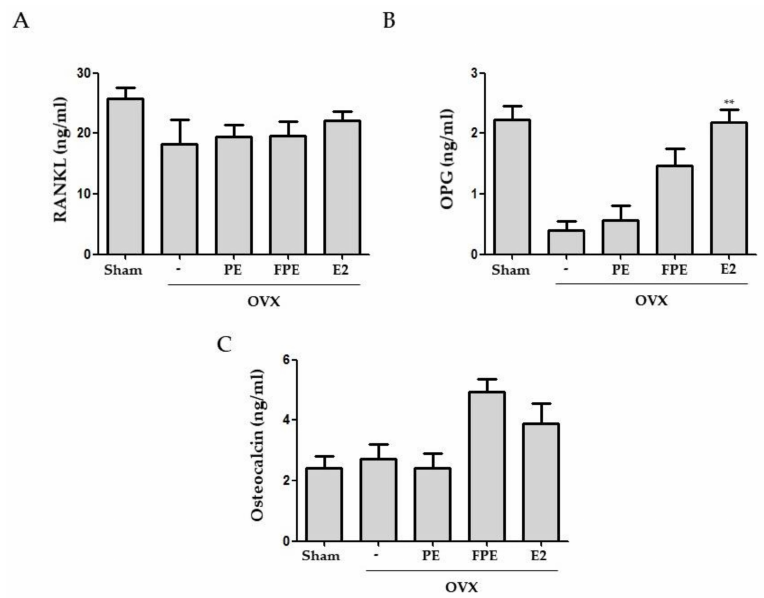
Figure 9. Serum levels of ( A ) RANKL, ( B ) OPG, and ( C ) osteocalcin measured by